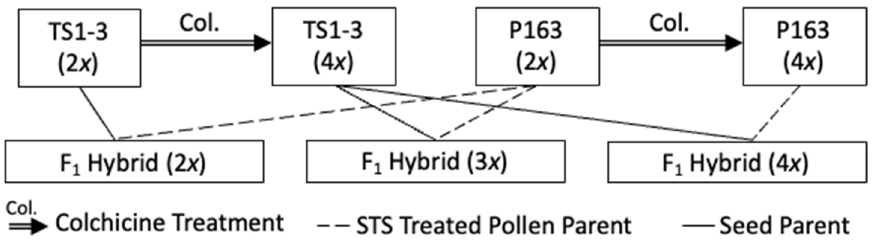
Figure 1. Crossing combinations used to produce diploid, triploid, and tetraploid F 1 hybrid C. sativa plants. Colchicine treatments were applied on commercial inbred lines ‘TS1-3’ and ‘P163’ to produce tetraploid versions. The silver thiosulfate (STS) treatment was applied to ‘P163’ and ‘P163 (4 x )’ plants to produce viable pollen. The diploid, triploid, and tetraploid F 1 hybrids were made from crossing combinations of TS1-3 (2 x ) × P163 (2 x ), TS1-3 (4 x ) × P163 (2 x ), and TS1-3 (4 x ) × P163 (4 x ).